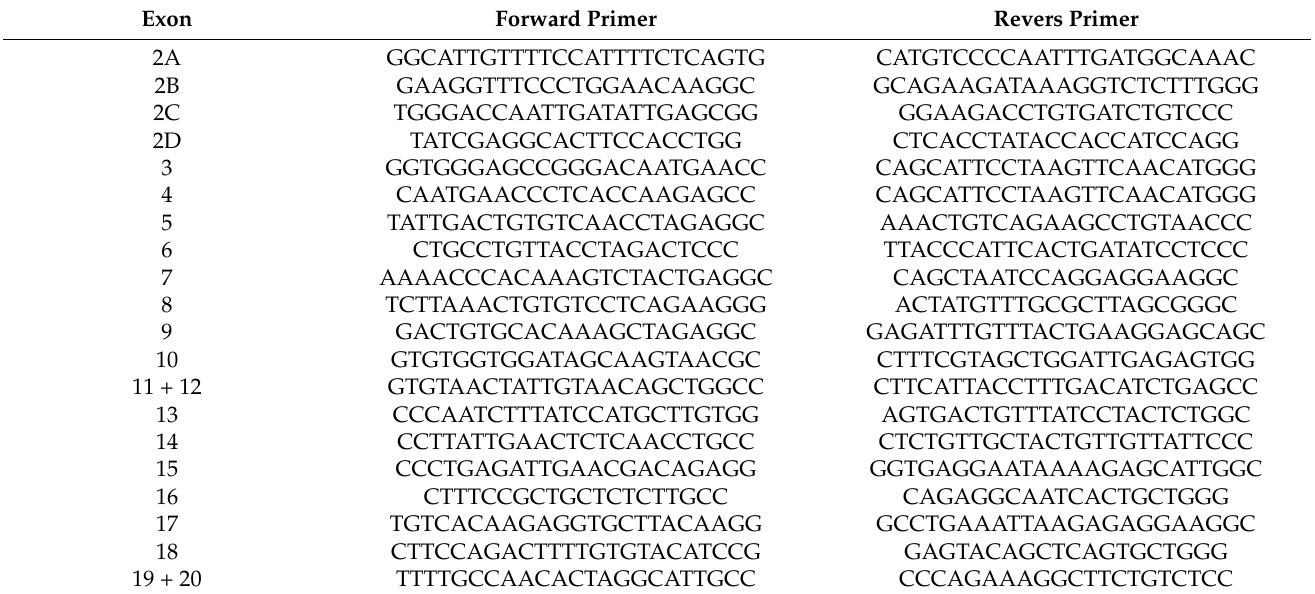
Table 1. Primers for exon amplification of the ATP7B